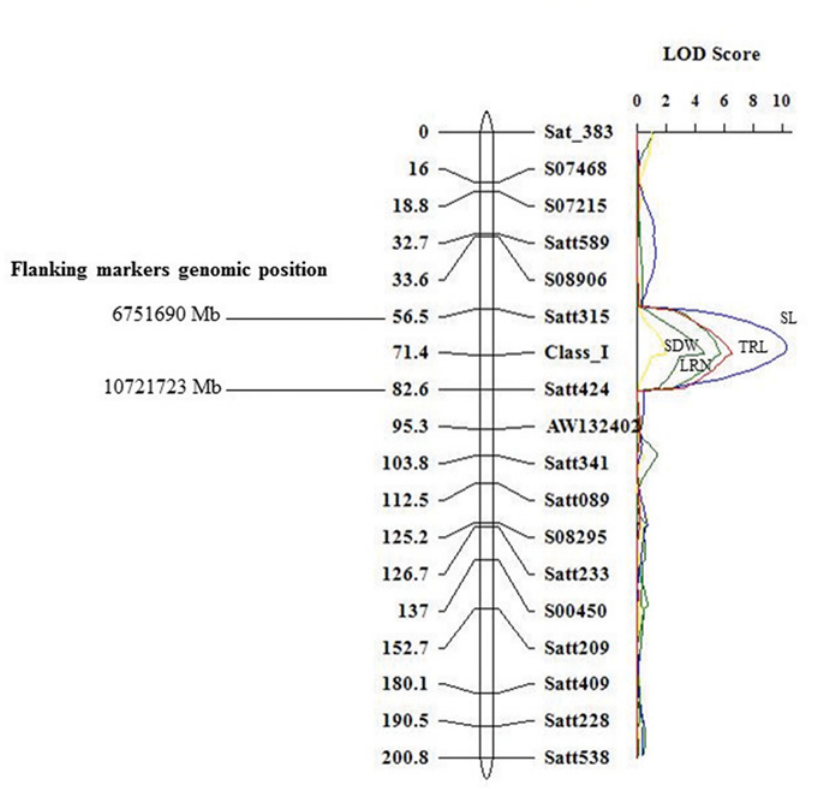
Fig 4. QTLs for root and shoot traits identified on chromosome 8 using inclusive composite interval mapping